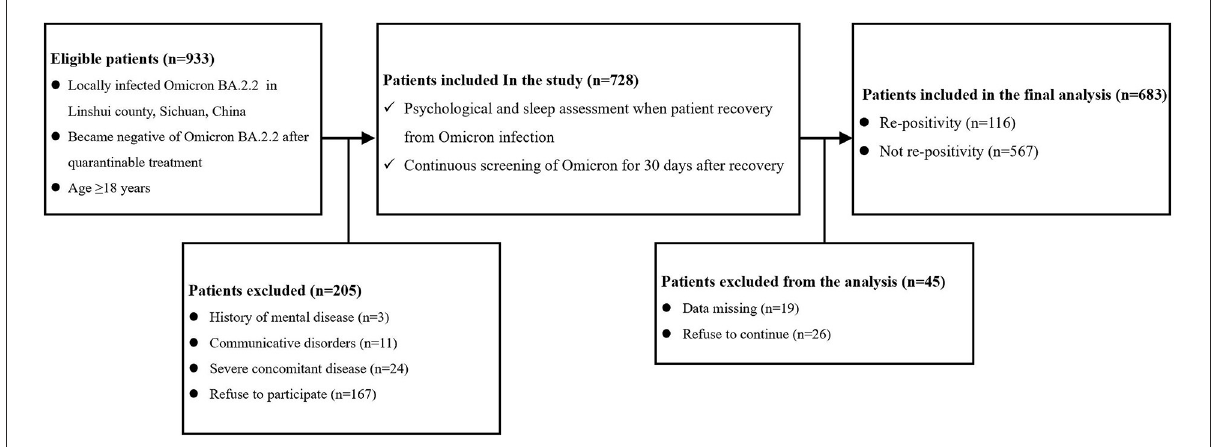
FIGURE1 Flow chart of the study. (Complication means diseases of different systems [including the cardiovascular, respiratory, urinary, digestive, nervous, and hematological systems, etc.]; Severe concomitant disease means accompanying severe disease requiring hospitalization).